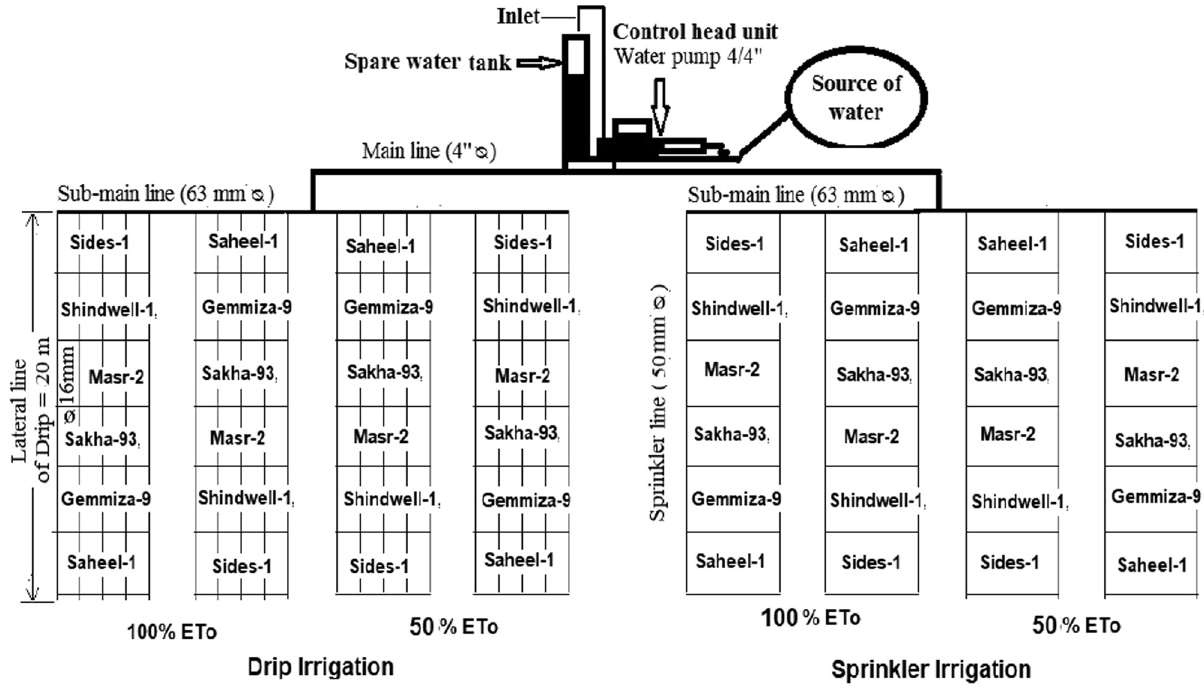
Figure 3: Layout of irrigation systems, study factors and all treatments of the fi eld